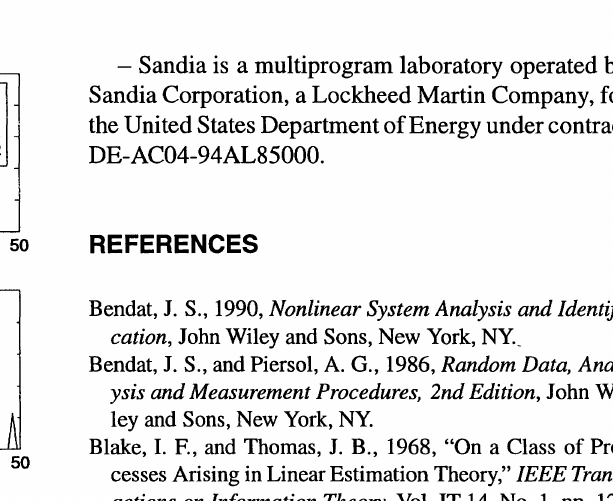
FIGURE 13 Probability density function of Student